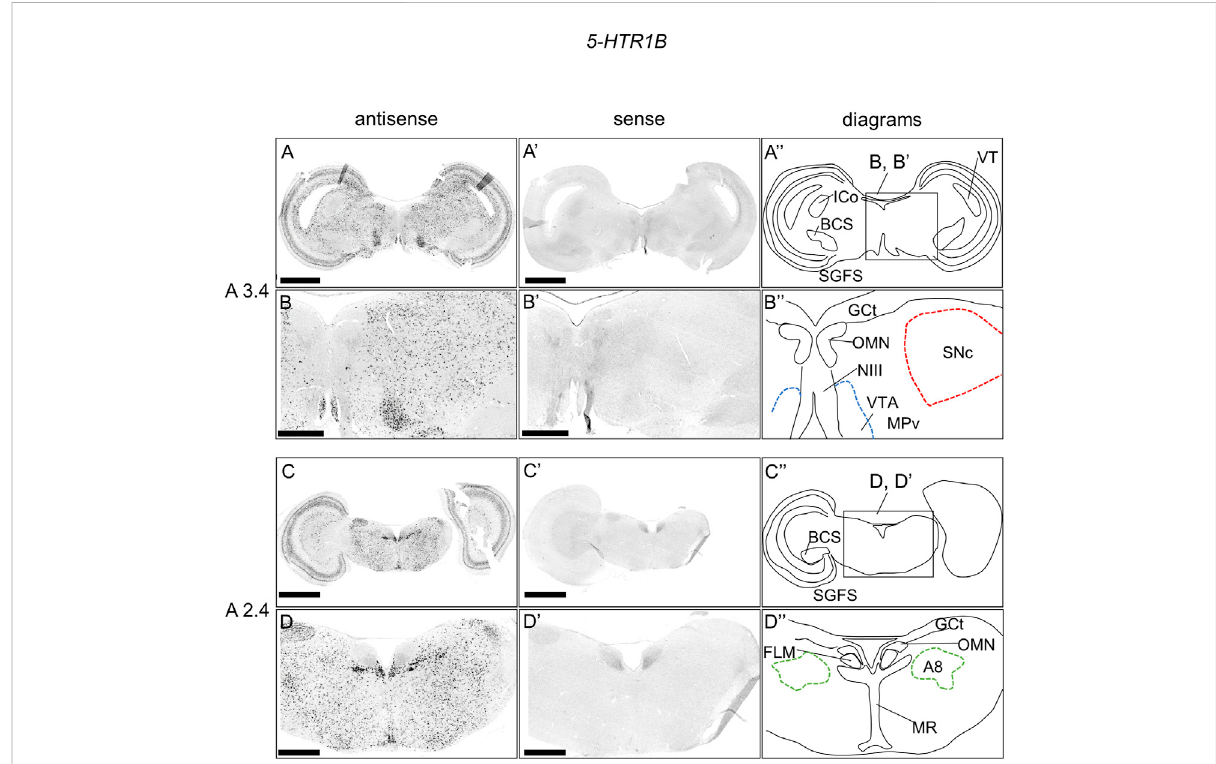
FIGURE 3 In situ hybridization of 5-HTR1B in the P1 chick brainstem. Digoxigenin-labeled RNA antisense (A – D) and sense ( A 9 – D 9 ) 5-HTR1B probes were used for in situ hybridization in coronal sections of P1 chick brainstems. To evaluate the expression patterns of 5-HTR1B , we analyzed sections from fi vechick brainstems;representativeimagesofchick brainstemsectionsareshown. (B) and (B 9 ) and (D) and (D 9 ) Magni fi edviewsofbrainareasinthe boxin (A 99 ) and (C 99 ) . (A 99 – D 99 ) Diagramsofcoronalsectionsshownintherightmostpanels.Thelevelsofexpressioninsections(A3.4andA2.4) were in accordance with those mentioned in the Kuenzel and Masson ’ s chick atlas (Kuenzel and Masson, 1988). A8: A8 cell group; BCS, brachium colliculi superiors; FLM, fasciculus longitudinalis medialis; GCt, griseum centrale; ICo, nucleus intercolicularis; MR, median raphe; NIII, nervus oculomotorius; OMN, oculomotor nucleus; P1, post-hatch day 1; PPT, pedunculopontine tegmental nucleus; SGFS, stratum griseum et fi brosum super fi ciale; SNc, substantia nigra pars compacta; VT, ventriculus tecti mesencephalic; VTA, ventral tegmental area. Scale bars = 2.5 mm (A,C) and (A 9 ,C 9 ) and 1 mm (B,D) and (B 9 ,D 9 )